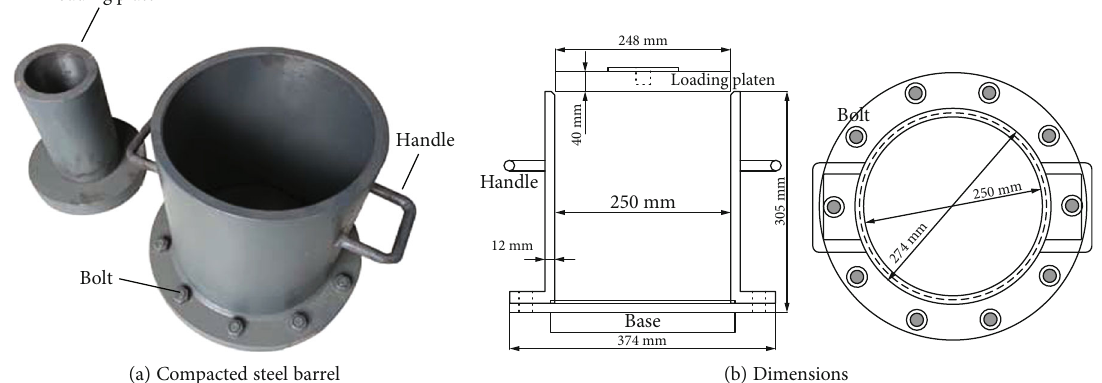
Figure 1: Compacted steel barrel and dimensions.